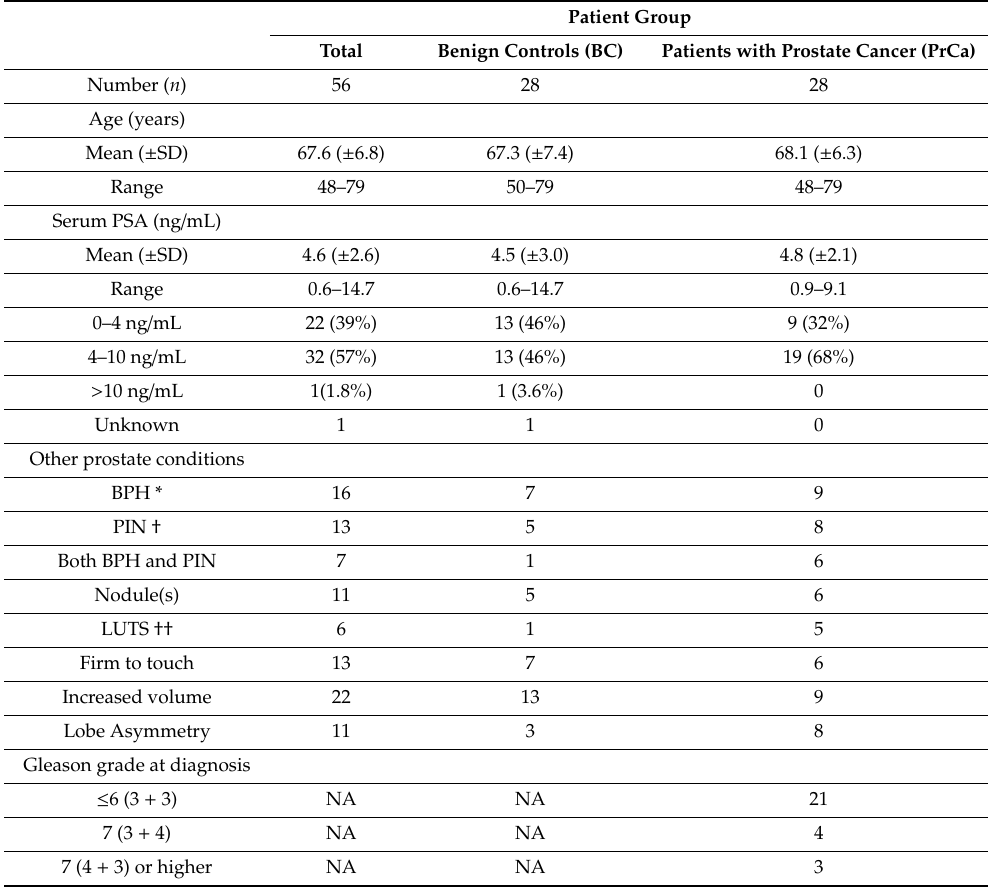
Table 1. Clinicopathological characteristics of patients enrolled in the